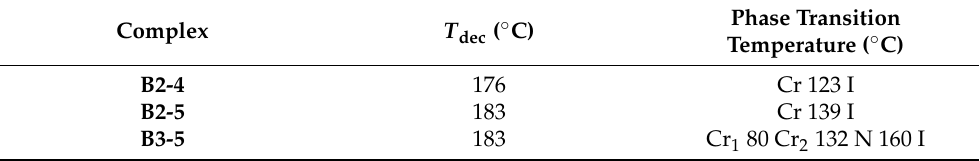
Table 2. Thermo-chemical properties and phase transition behaviors of B x - y